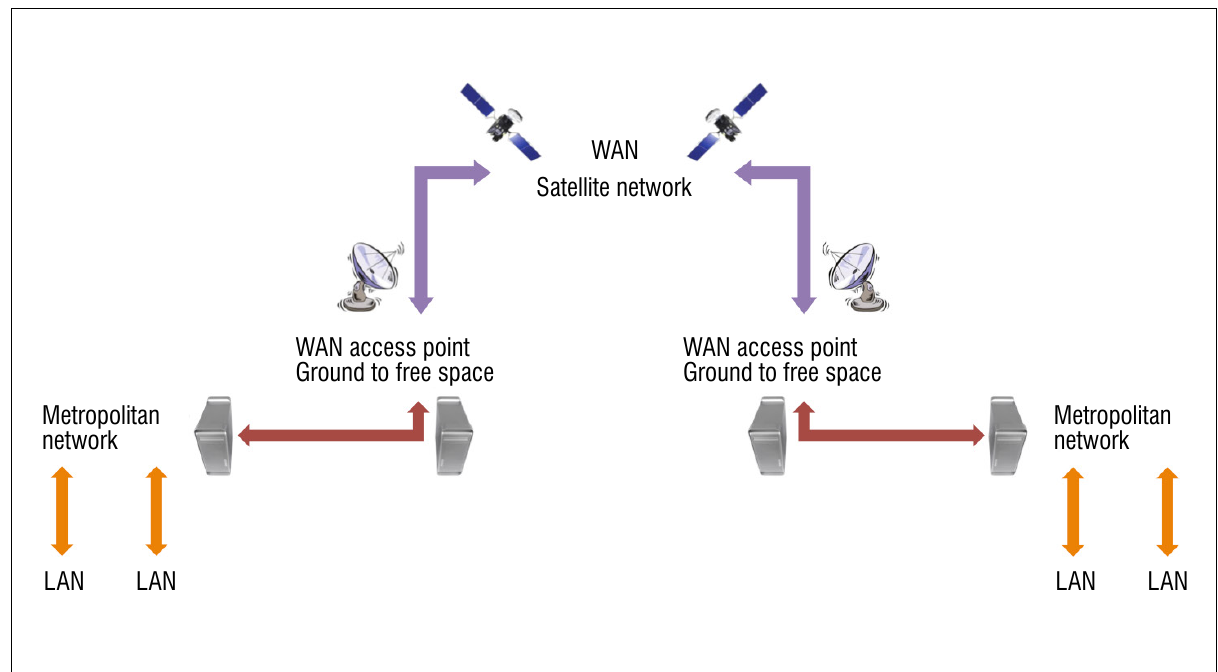
A diagram depicting a potential set-up for a global quantum key distribution network.